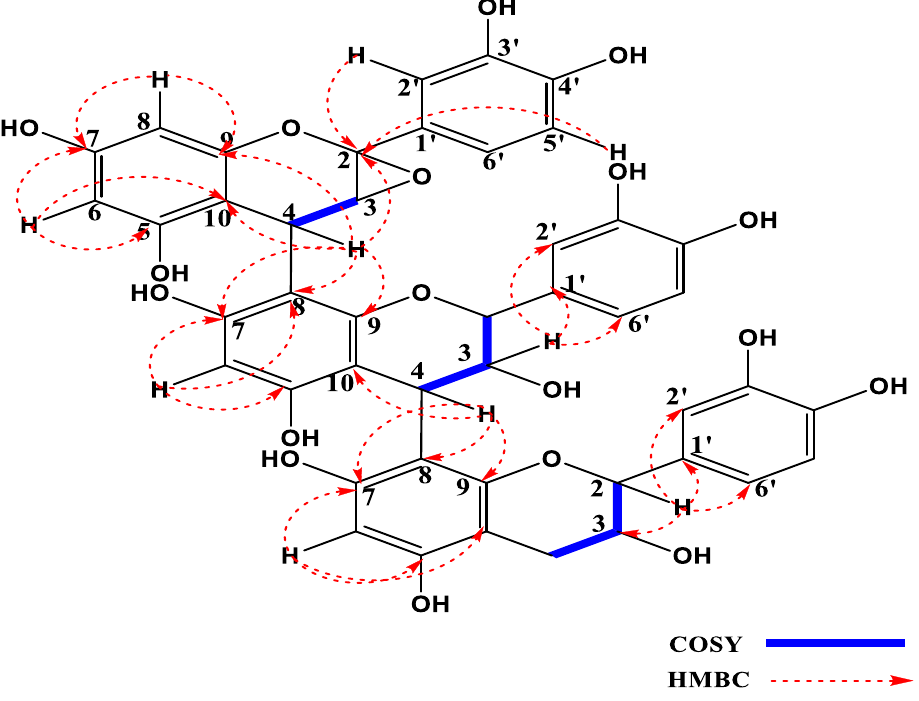
Figure 1. HMBC and COSY correlations of compound 1 (2,3-Epoxyprocyanidin C1).